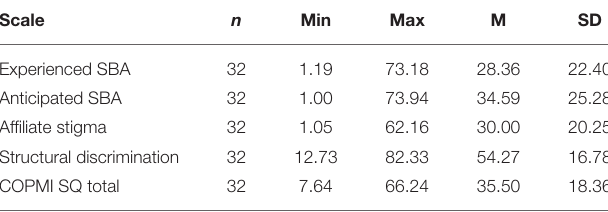
TABLE 3 | Sample characteristics revised instrument version COPMI-SQ. TABLE 4 | Changes in the instrument structure through internal consistency